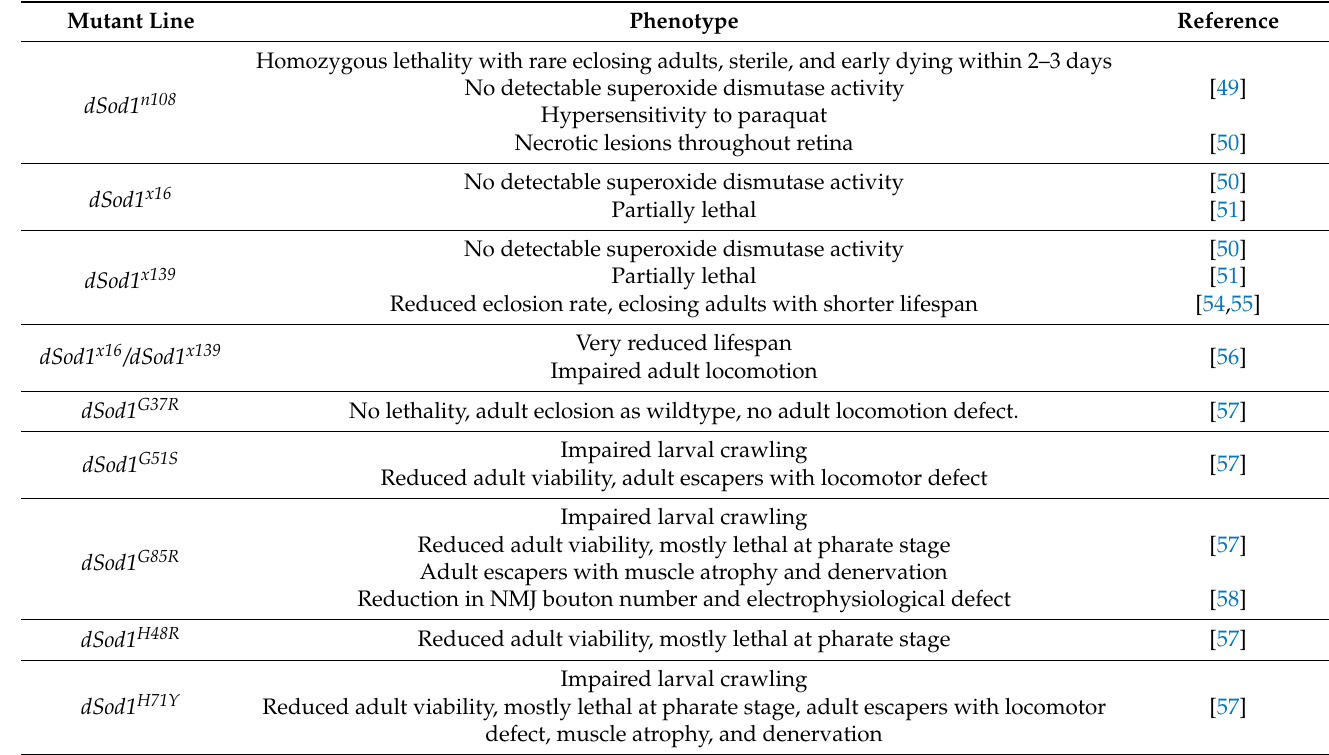
Table 1. Phenotypes observed in dSod1 ( superoxide dismutase-1) mutant backgrounds. Mutant